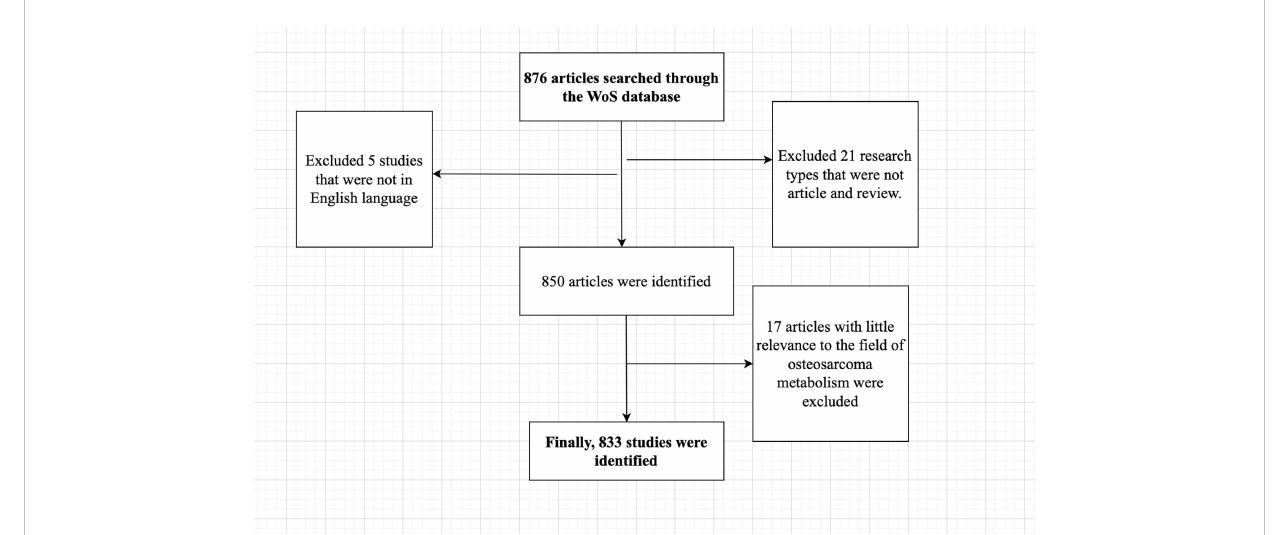
FIGURE 1 Diagram of the process of screening